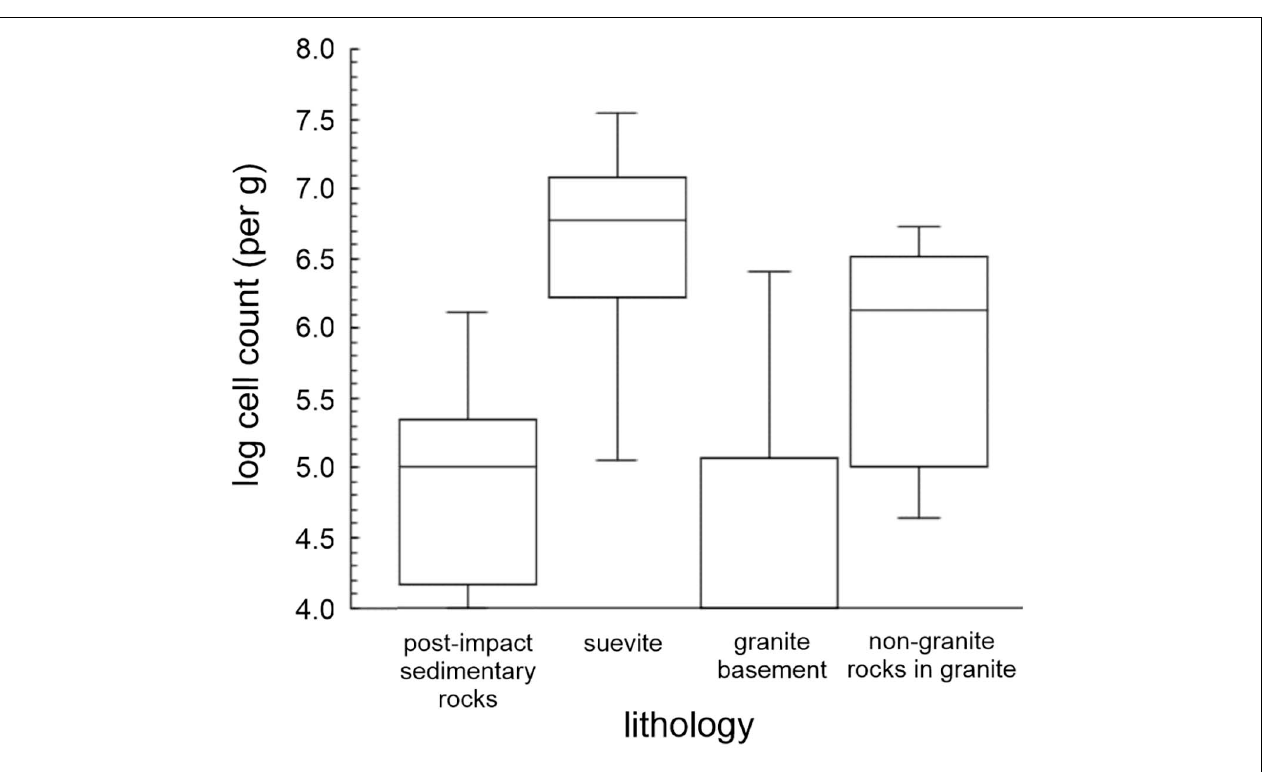
FIGURE 3 | Box plots of cell numbers associated with Chicxulub impact lithologies. Lithologies shown are postimpact sedimentary rocks, suevite (cell enumerations in all suevite units), granite basement alone (elevated cell counts in non-granitic material removed), and non-granite rocks in the granitic unit (i.e., geological interfaces within the granitic unit). Logarithmically transformed data are shown as a box